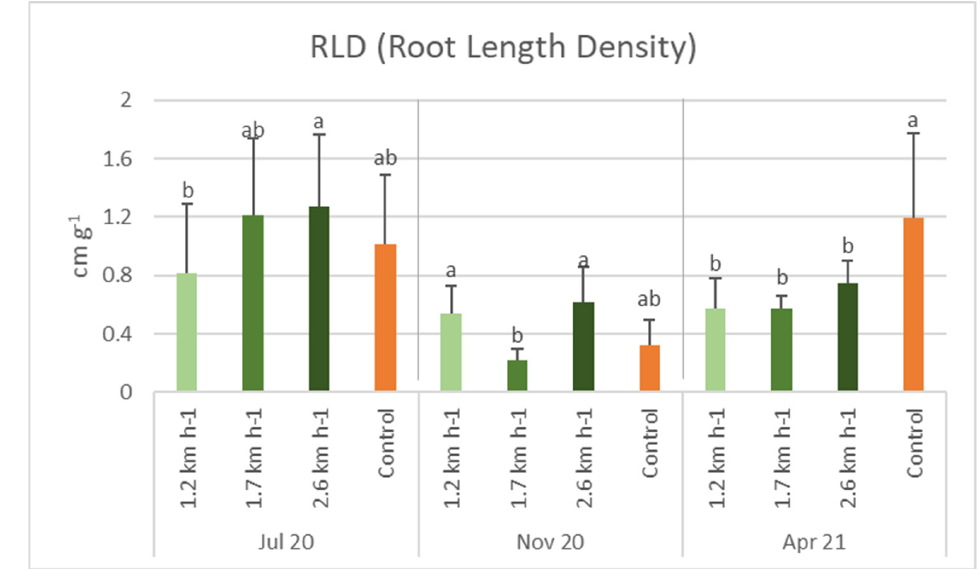
Figure 9. Root length density (RLD, measured as total root length soil weight − 1 ) in the three sampling dates. 1.2 km h − 1 , 1.7 km h − 1 and 2.6 km h − 1 indicate the Grass Killer treatments at 1.2, 1.7 and 2.6 km per hour working speeds, respectively. Control = hoeing machine. Data are means ± standard deviation, different letters indicate significant differences within each sampling date according to Tukey–Kramer HSD test ( p < 0.05).